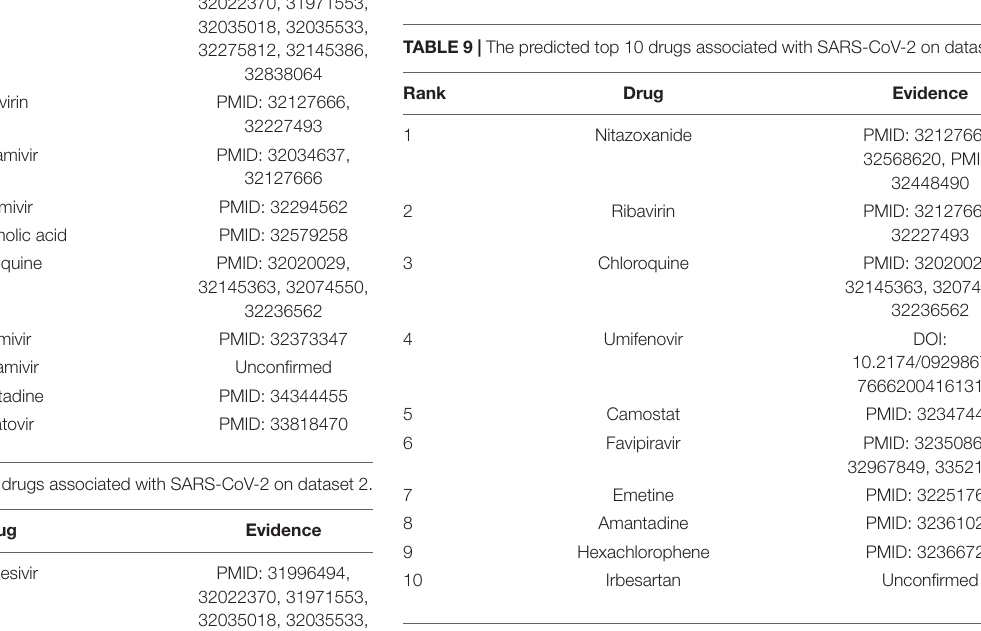
TABLE 10 | Binding energy between the predicted antiviral drugs and the junction of the S protein-ACE2